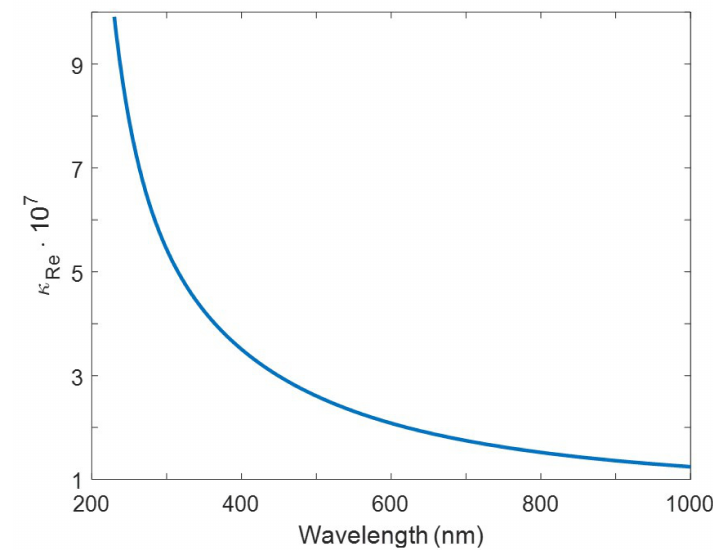
Figure 3. Model function for the chirality κ of a D-glucose